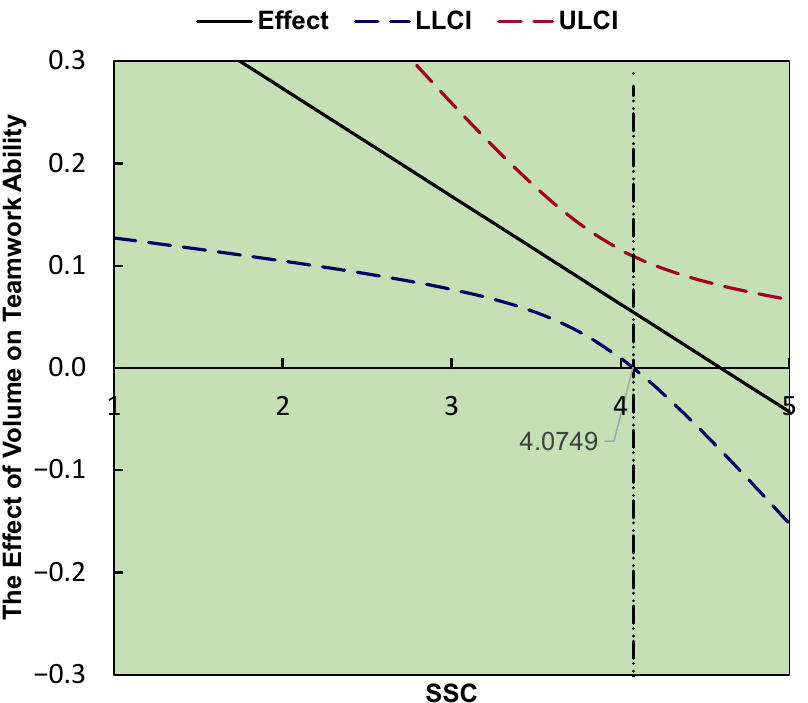
Figure 4. J–N. The dotted line “ULCI” represents the upper limit of the confidence interval, and “LLCI” represents the lower limit of the confidence interval. The line “Effect” represents the effect of volume on teamwork ability.